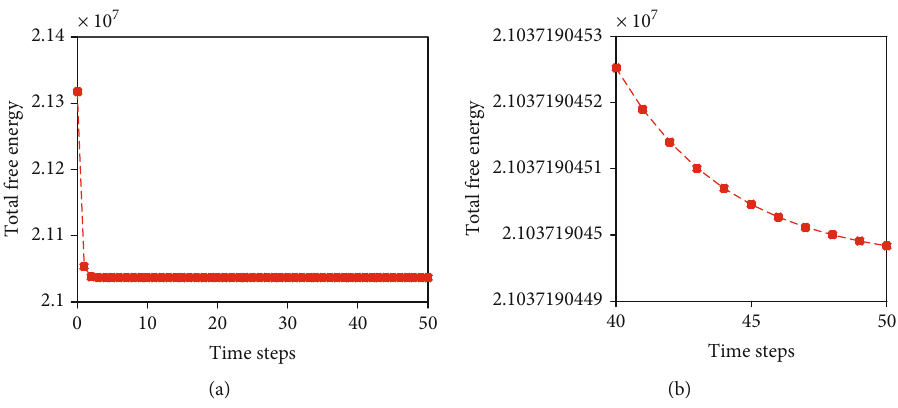
Figure 5: Total energy pro fi les of the proposed model in example